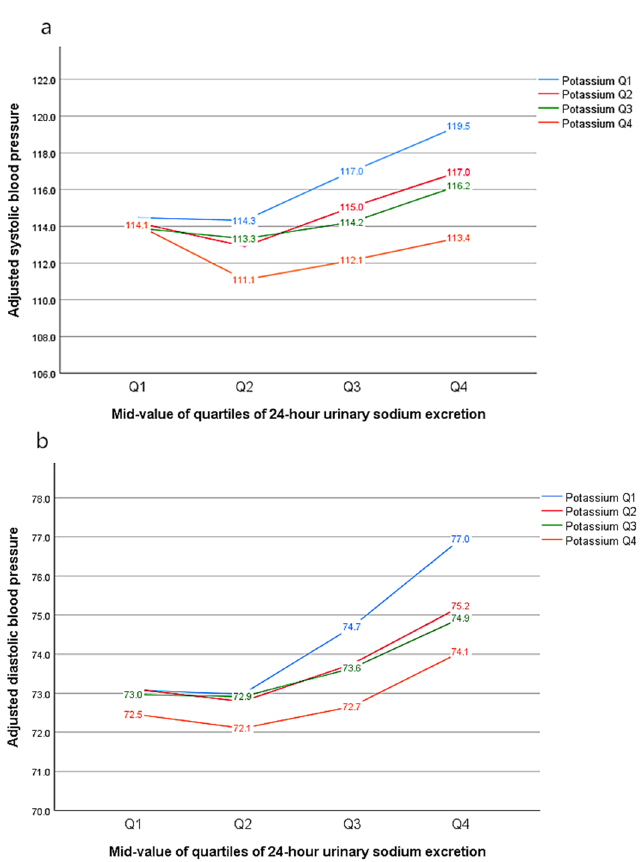
Figure 2. Adjusted SBP and DBP in the quartiles of 24-h urinary sodium and potassium excretion. This figure presents adjusted systolic blood pressure ( a ) and adjusted diastolic blood pressure ( b ) at the 12.5th, 37.5th, 62.5th, and 87.5th percentiles of 24-h urinary sodium and by the quartiles of potassium